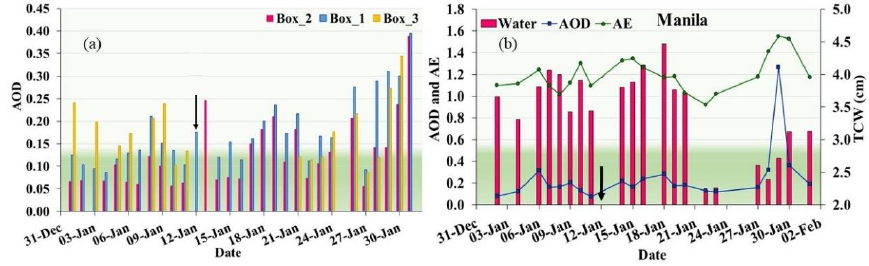
Figure 6. ( a ) Temporal variations of aerosol optical depth (AOD) over Boxes 1, 2, and 3 during January 2020 using Aqua and Terra MODIS data. ( b ) Temporal variations of AOD, AE, and TCW at the Manila AERONET station (b). The black downward arrow is the day of the volcanic